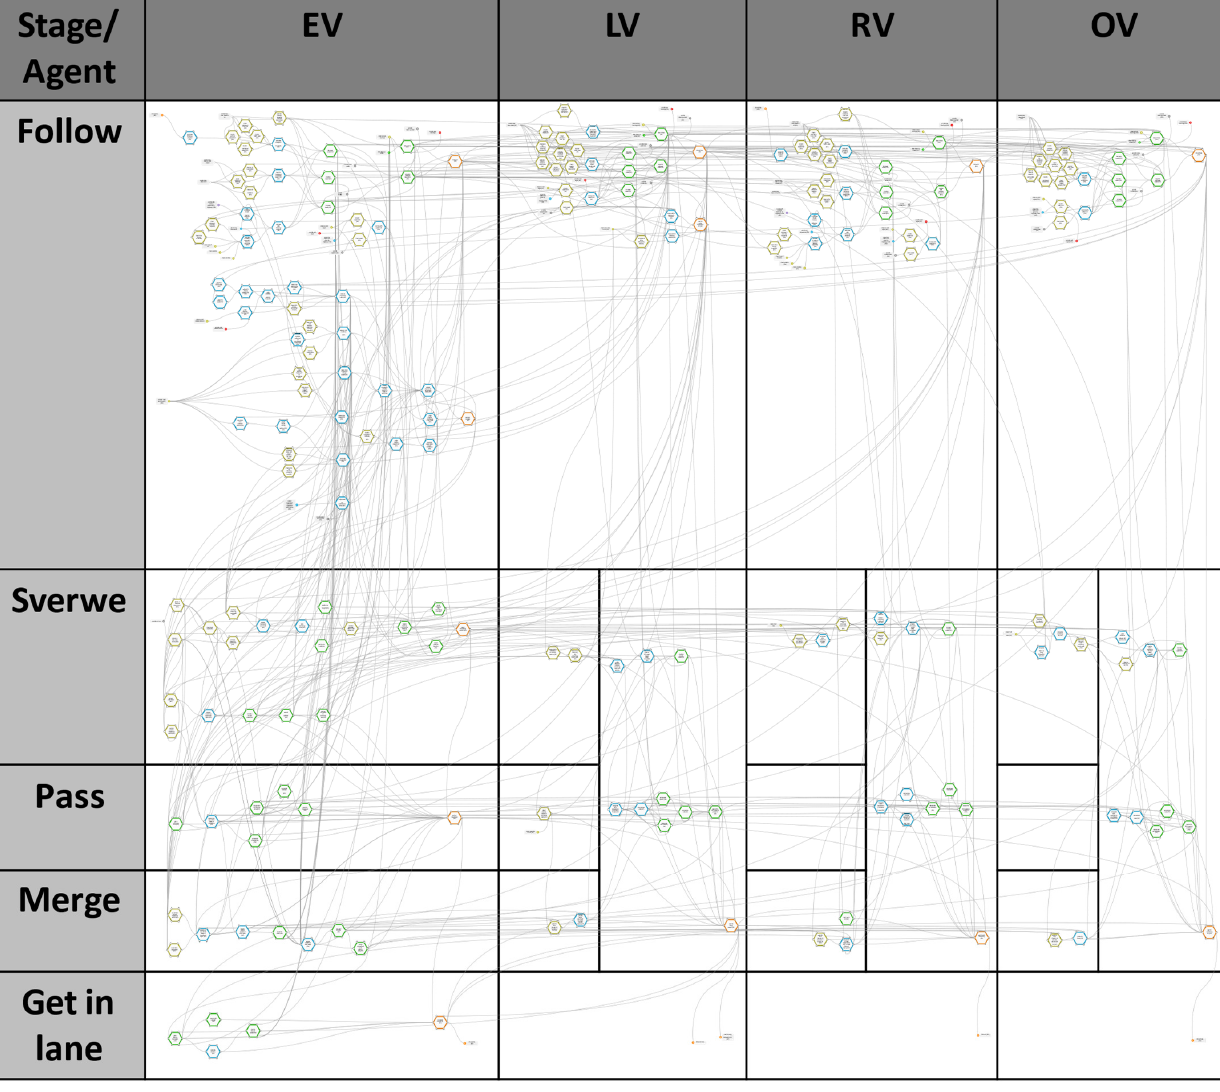
Figure 5. The overall FRAM model assigned in the Space-Time/Agency framework.